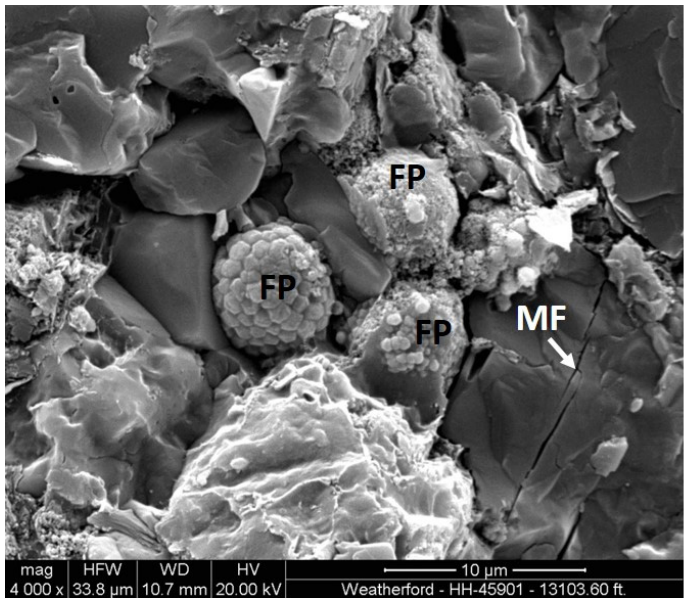
Figure 3. SEM (Scanning electron microscopy) image of a gas shale retrieved from a depth of 3994 m belonging to a core from the Bossier–Haynesville formation of East Texas Basin. Framboiydal pyrite (FP) is seen, with the pyrite replacing the calcite particle. Micro fracturing (MF) of constituent mineral can be